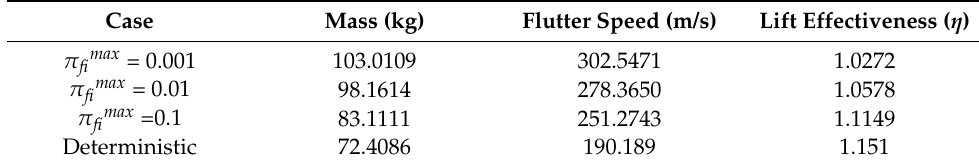
Table 2. Optimum solutions for the aircraft wing design.